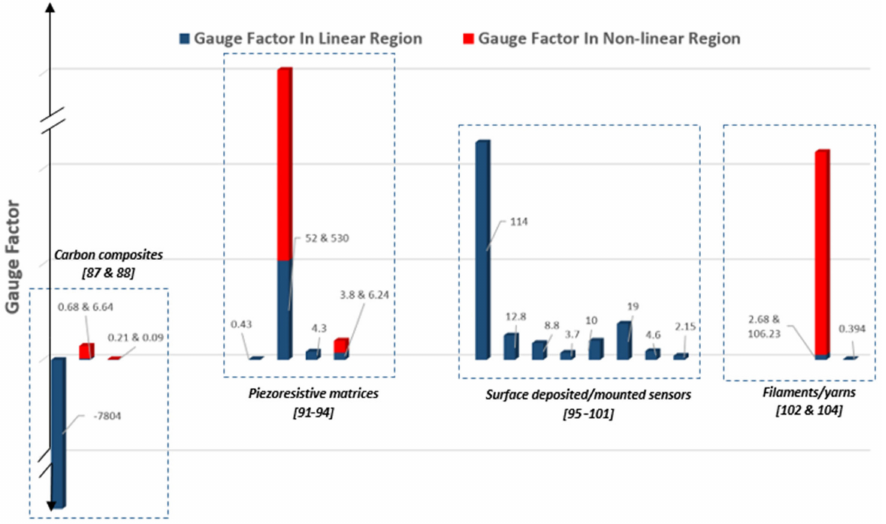
Figure 13. Gauge factors reported for the four different types of piezoresistive sensing